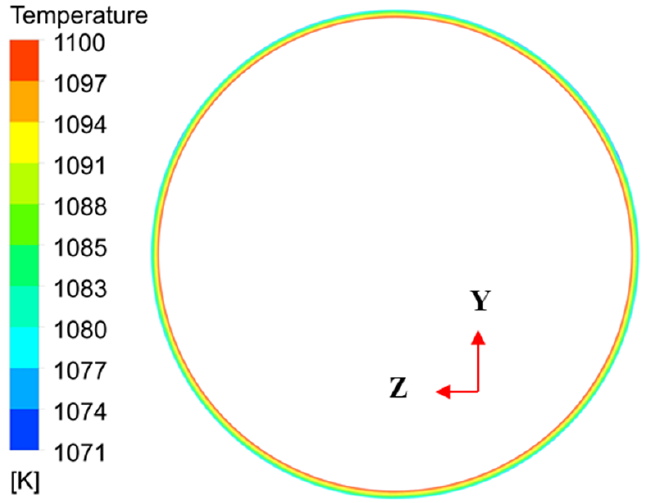
Figure 11. Temperature contour of a Y – Z section of the closed cavity.